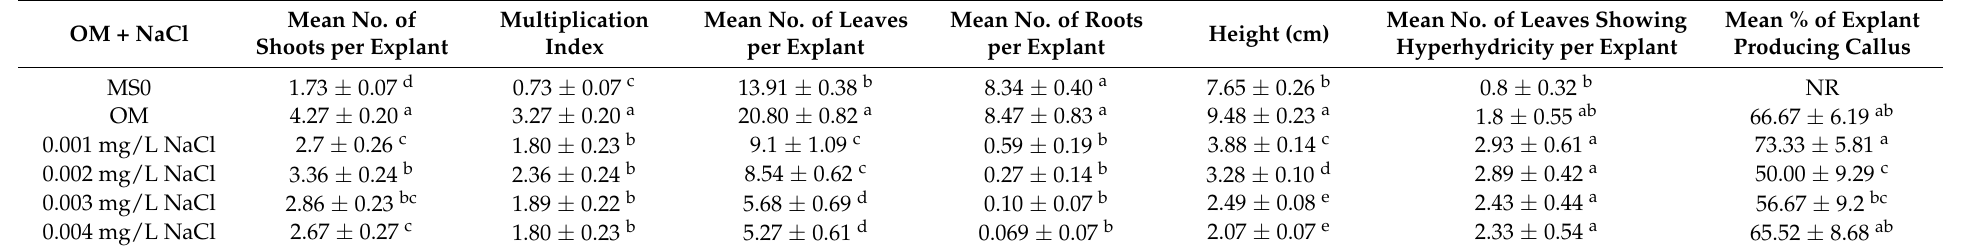
Table 4. Effects of salt stress on mean number of shoots, multiplication index, leaves and roots per explant, mean percentage (%) of explant producing callus, height and mean number of leaves showing vitrification (hyperhydricity) per explant.